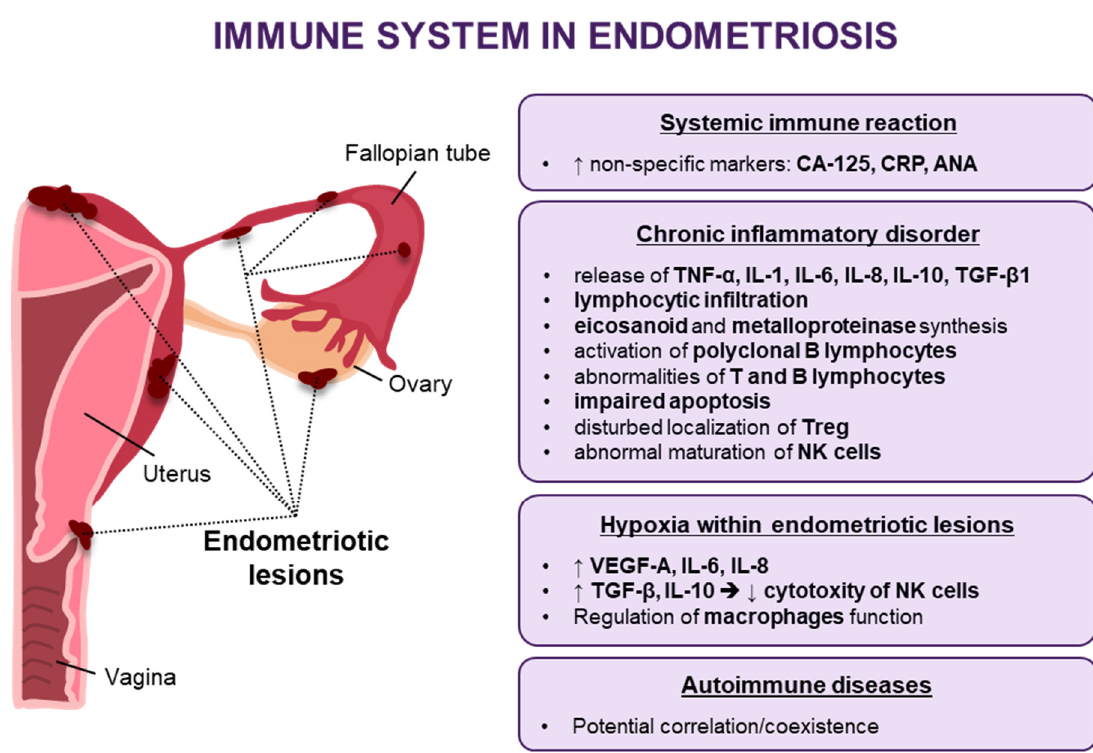
Figure 1. Dysregulation of the immune response in endometriosis ( ↑ − increased , ↓ − decreased, → − lead to).